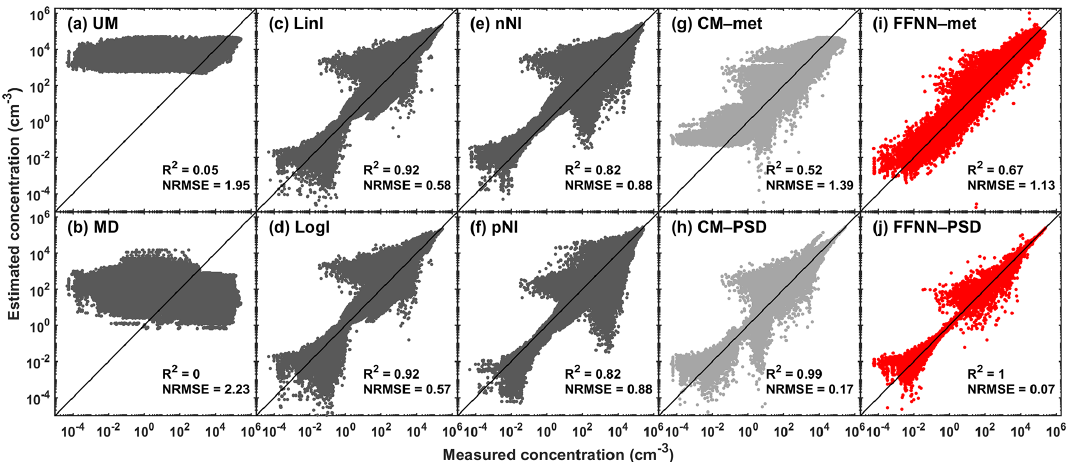
Figure 9. Scatter plots showing the estimated particle concentration ( y axis, in cm − 3 ) against the in situ-measured particle concentration ( x axis, in cm − 3 ). (a–f) Univariate methods including unconditional mean (UM), median (MD), linear interpolation (LinI), logarithmic interpolation (LogI), next-neighbour interpolation (nNI) and previous-neighbour interpolation (pNI), respectively, in dark grey dots. (g– h) Multivariate methods including conditional mean by regression of meteorological parameters and other particle size number concentrations as inputs (CM–met and CM–PSD, respectively) in light grey dots. (i–j) The proposed feed-forward neural network with meteorological parameters and other particle size number concentrations as inputs (FFNN–met and FFNN–PSD, respectively) in red dots. The black solid line is the 1 : 1 line, which gives a reference of perfect estimation. The coefficient of determination ( R 2 ) and the normalised root-mean-square error (NRMSE) of each method for all particle size bins are shown on the corresponding subplots.